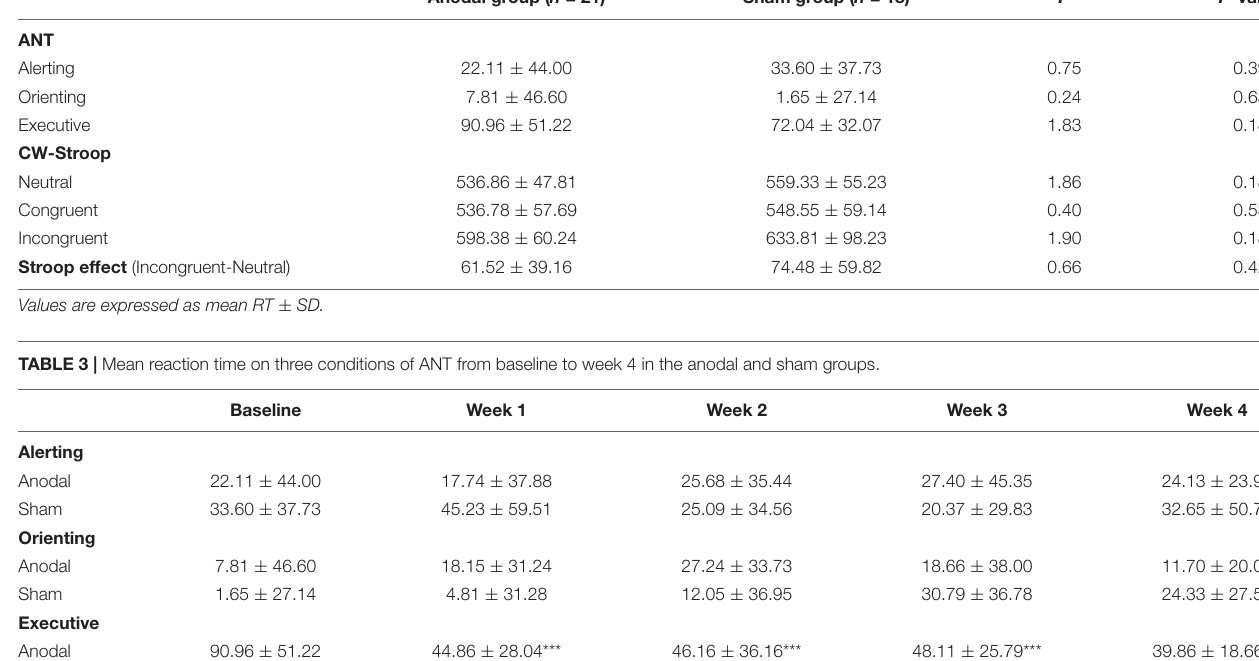
TABLE 2 | Mean reaction time of baseline on each condition of ANT and CW-Stroop, and Stroop effect in the anodal and sham groups. Anodal group ( n = 21) Sham group ( n = 18) F P -value